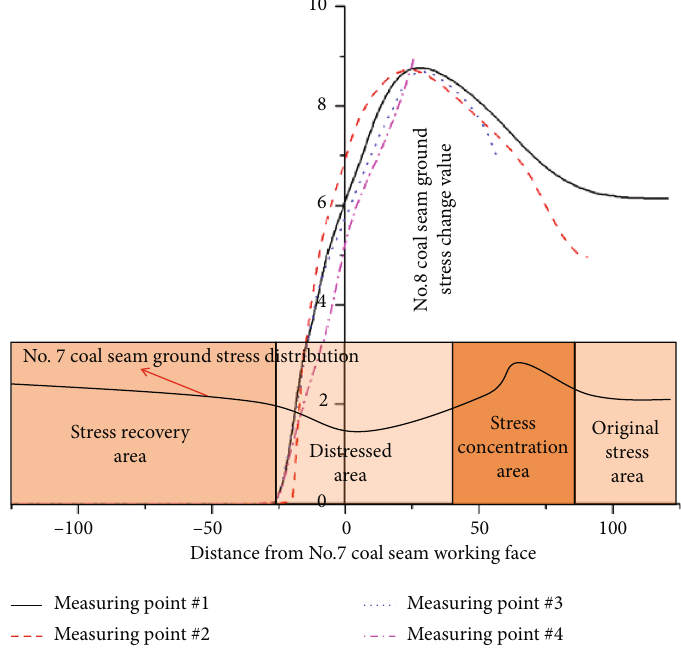
Figure 5: The fi gure of stress measuring points.